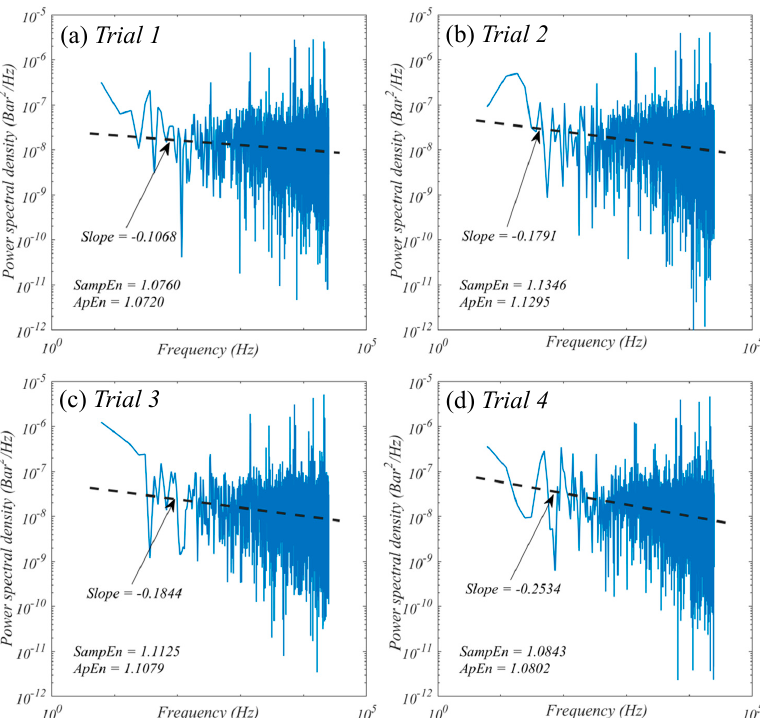
Figure 6. Power spectral density across frequency for four different discharges, ( a ) Trial 1, ( b ) Trial 2, ( c ) Trial 3, and ( d ) Trial 4 for point P 1, where β = slope of PSD (see details in (13)). The SampEn and ApEn numerical values are displayed within each subplot.